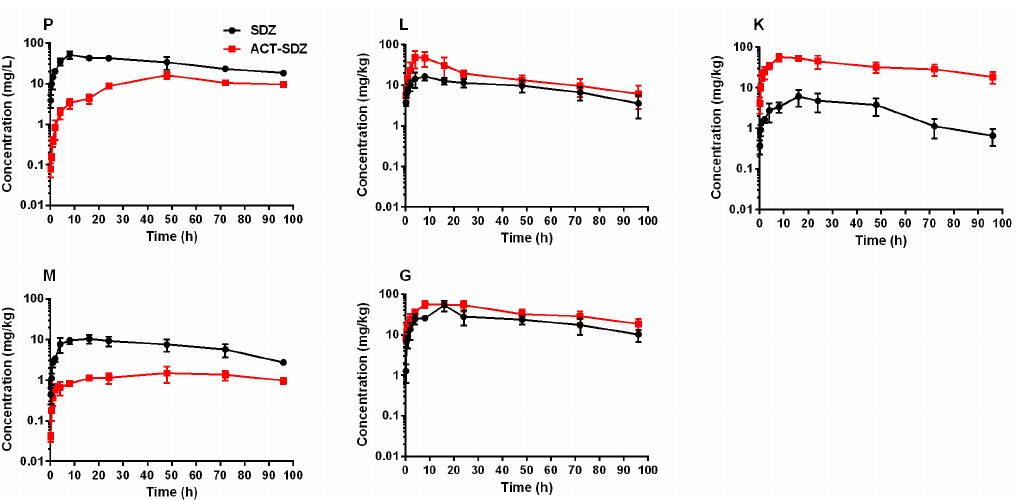
Figure 1. Semi-logarithmic concentration-time profiles of sulfadiazine and its main metabolite N-acetyl sulfadiazine in plasma ( P ), liver ( L ), kidney ( K ), muscle+skin ( M ), and gill ( G ) of grass carp ( Ctenopharyngodon idella ) following a single oral dose of sulfadiazine at 50 mg/kg at 18 °C. Abbreviations on the figure: SDZ, sulfadiazine; ACT-SDZ, N-acetyl sulfadiazine.